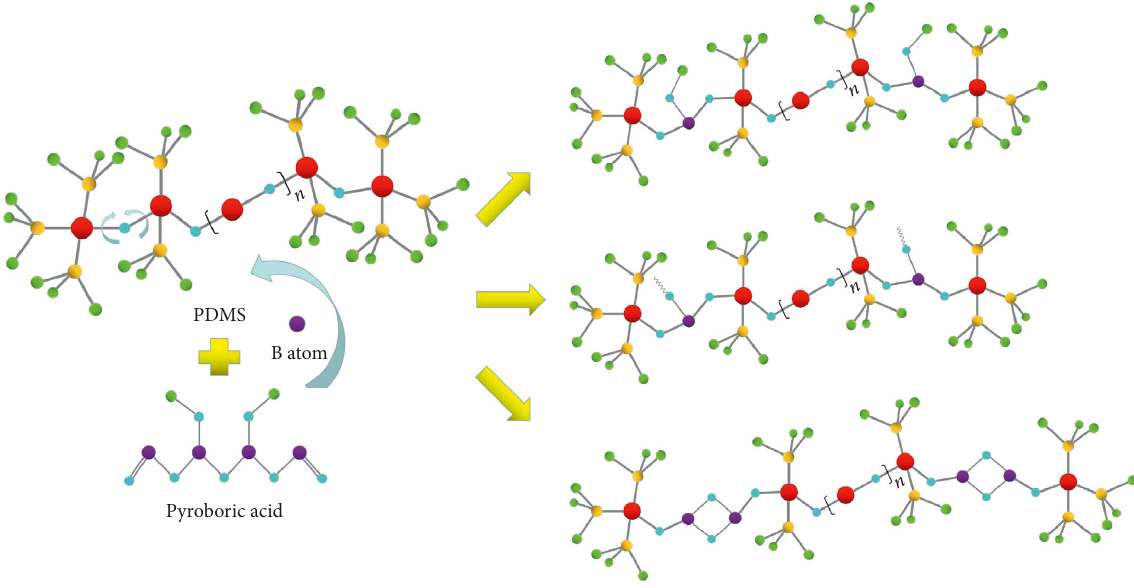
Figure 7: Three possible structural forms of the molecular chain doped with element B.